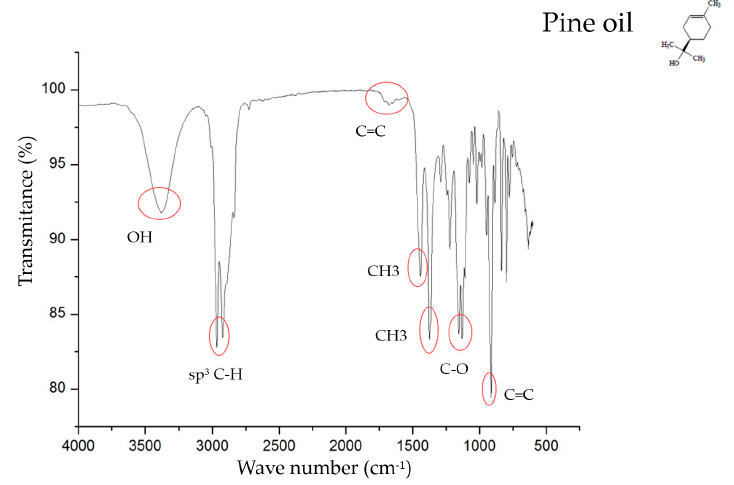
Figure 10. Infrared absorption spectrum of pine oil.